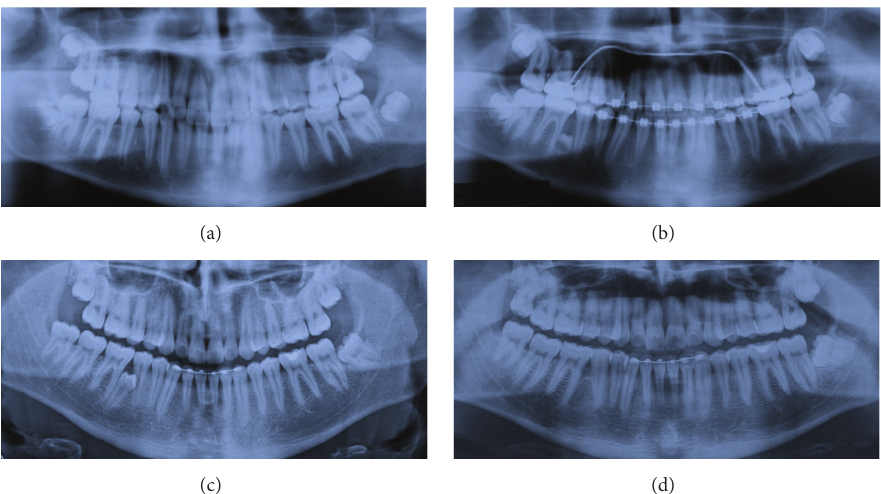
Figure 1: Case 1 radiography: before treatment 2004 (a), before rebonding, ST in 4.5–4.6 region, 2006 (b), 5 years after debonding 2011 (c), and after the extraction of the ST 2013